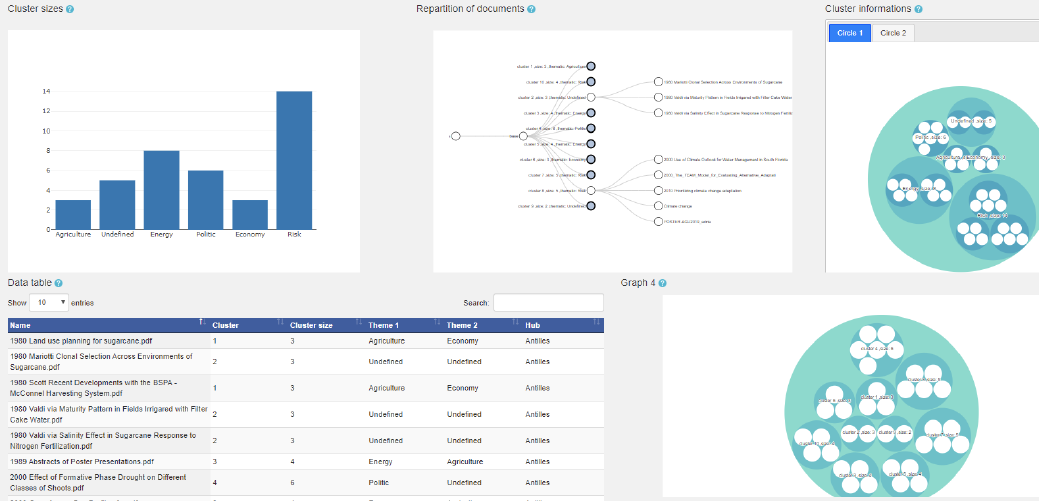
Figure 12. Text-mining results displayed on